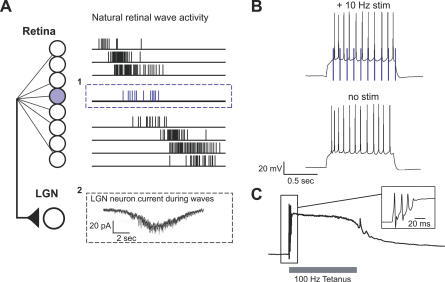
Generating In Vivo Activity Patterns(A) Schematic demonstrating natural activity resulting from retinal waves in the retina (top) and LGN (bottom): a retinal wave involves activity over a population of RGCs (#1) that evokes a large synaptic input in target LGN neurons (#2). Dashed boxes correspond to the two components of natural retinal wave activity reproduced in our experiments. Retinal wave multi-electrode recording data were adapted from Wong et al. [14]; LGN synaptic recording adapted from Mooney et al. [30](B) Retinal wave activity at the retinogeniculate synapse is reproduced by minimal 10-Hz stimulation to the OT (vertical blue lines) paired at a given latency with direct current injection into the recorded LGN neuron to evoke 10–20 Hz bursting (top). Participation of the selected synapse has negligible effect on LGN firing, as shown by comparing the depolarization paired with +100 ms latency OT stimulation (stim) (top) with depolarization alone (bottom).(C) This situation is in marked contrast to a tetanus protocol, which involves higher current stimulation (100 Hz for 1 s), resulting in a long-lasting depolarization largely absent of postsynaptic spiking.Scale bars for (B) and (C) are shown between these panels.